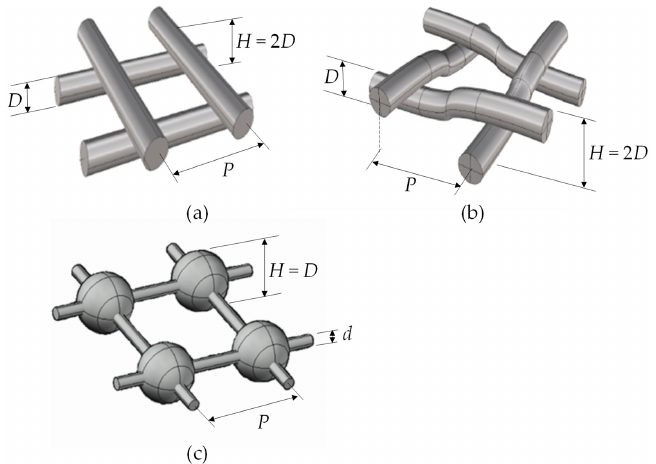
Figure 1. Schematic representation of the three geometries that were tested with main nomenclature: H = channel thickness, D = sphere diameter, P = pitch, d = diameter of the connecting rods. ( a ) overlapped; ( b ) woven; ( c ) spheres.